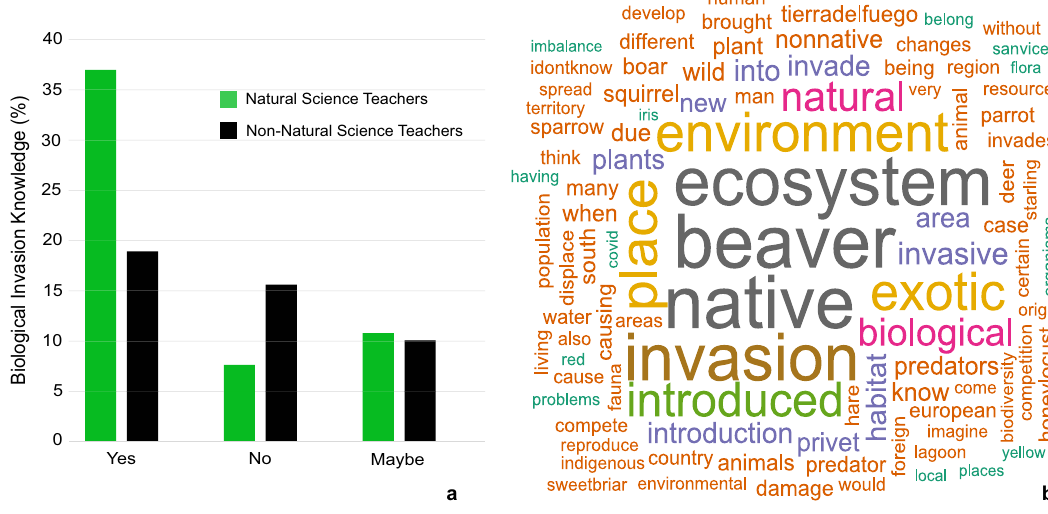
Figure 5. Biological invasions awareness from education community, ( a ) perception knowledge of Natural Science Teacher (NST) and non-NST, and ( b ) word cloud from text mining analysis of respondent knowledge about biological invasion. Bigger letter size implies more frequency of presence in